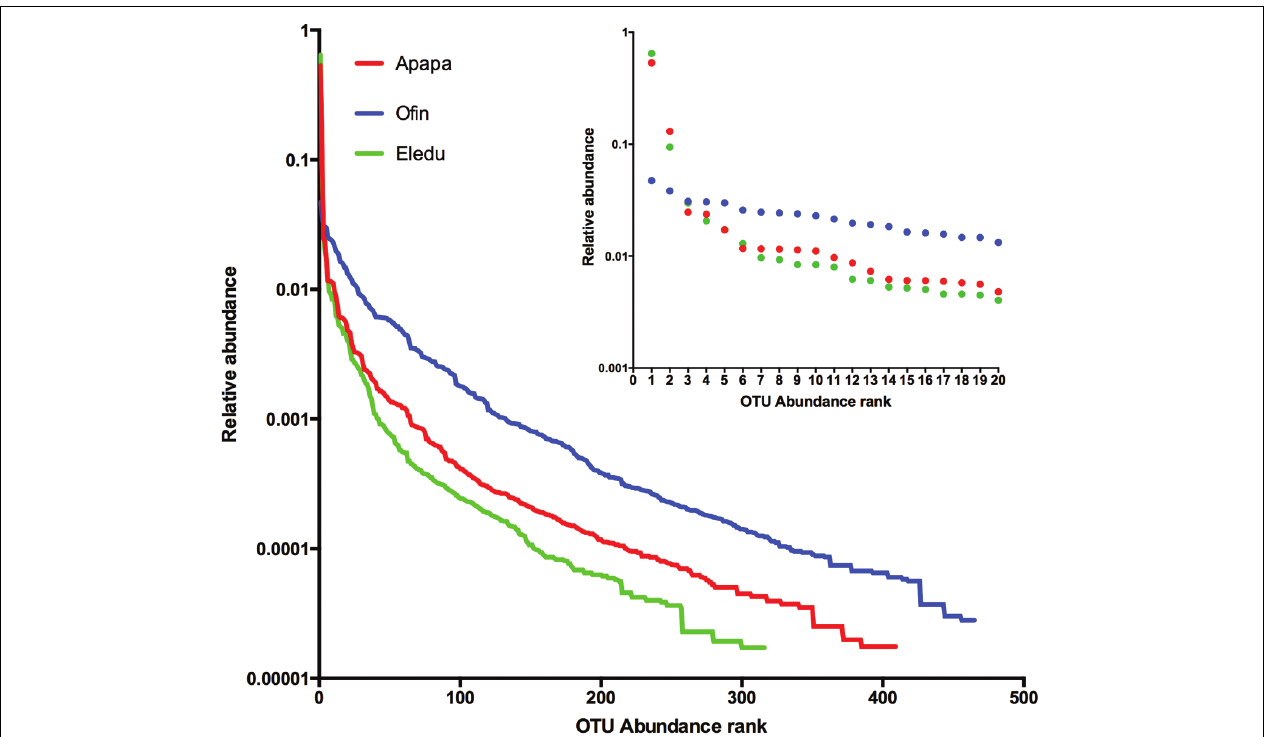
FIGURE 2 | Whitaker plots of average operational taxonomic unit (OTU) abundance in the sediment communities. For each sediment, OTU are plotted from most abundant (rank 1) to least. The large plot shows the entire data set for each sediment, while the inset shows a detailed view of the top 20 most abundant OTU in each